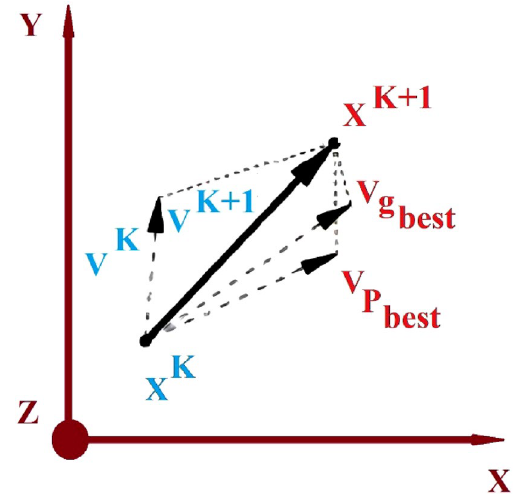
Fig. 8 Dislocation of the